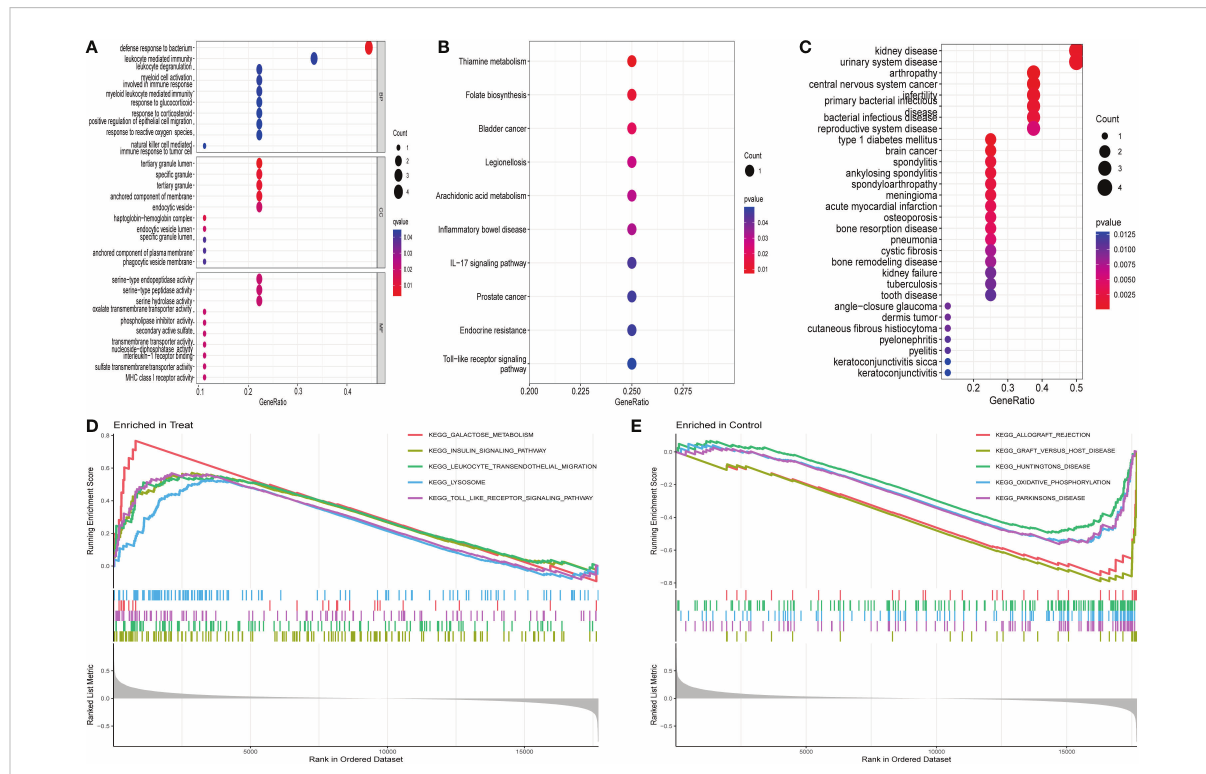
FIGURE 2 Enrichment analysis of differentially expressed genes: (A) GO enrichment analysis. (B) KEGG enrichment analysis. (C) Disease ontology enrichment analysis. (D, E) GSEA enrichment